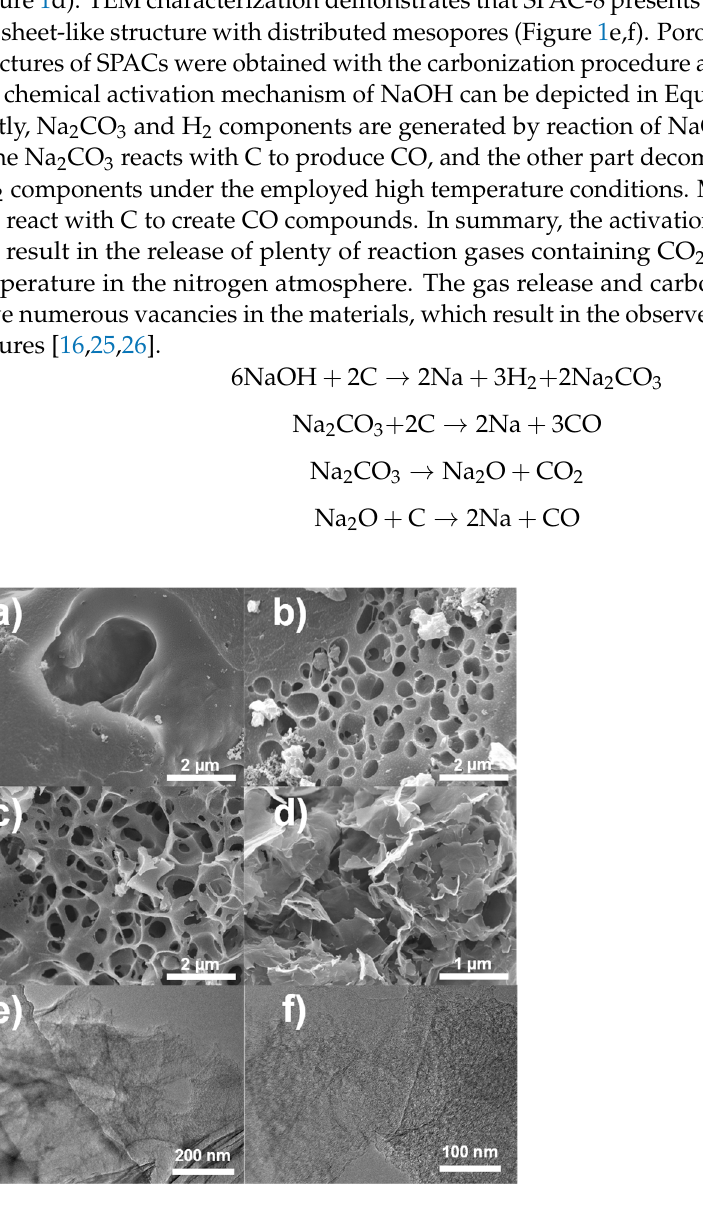
Figure 1. SEM images of SPAC-0 ( a ), SPAC-2 ( b ), SPAC-4 ( c ), SPAC-8 ( d ), and TEM images of SPAC-8 ( e ), ( f ).